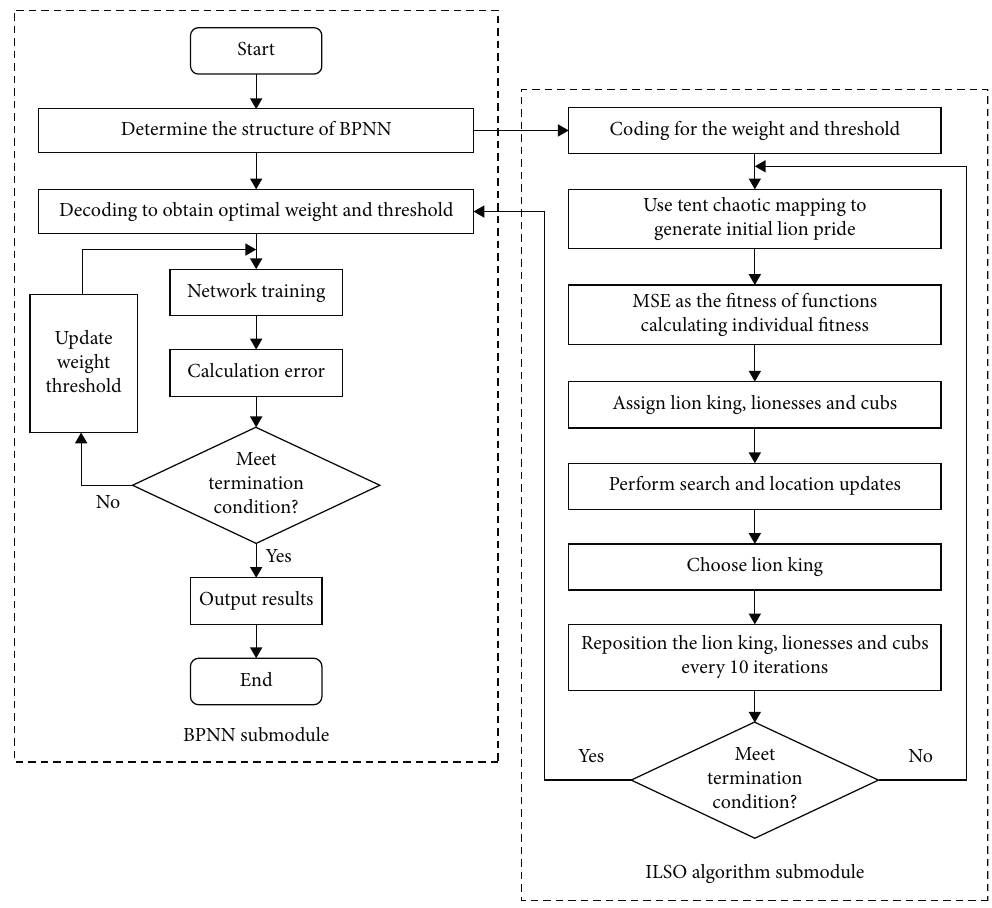
Figure 13: Flow chart of ILSO_BP